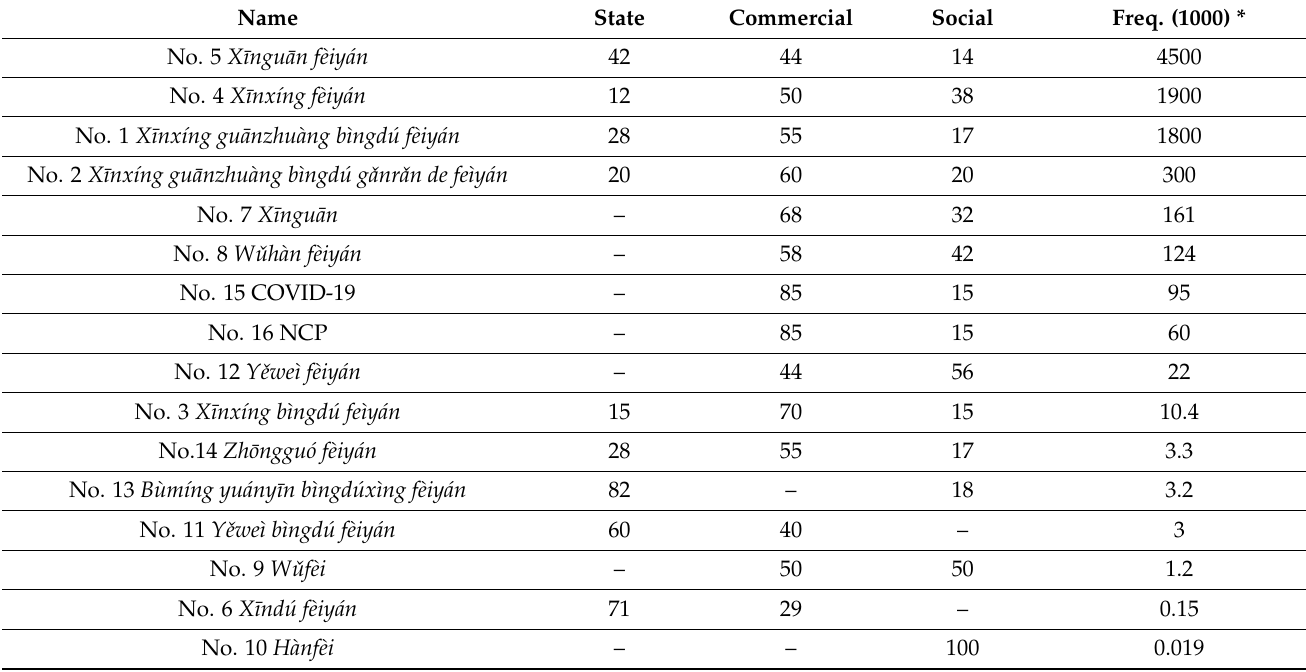
Table 6. Frequency and percentage distribution of the 16 pneumonia names; coronavirus name study